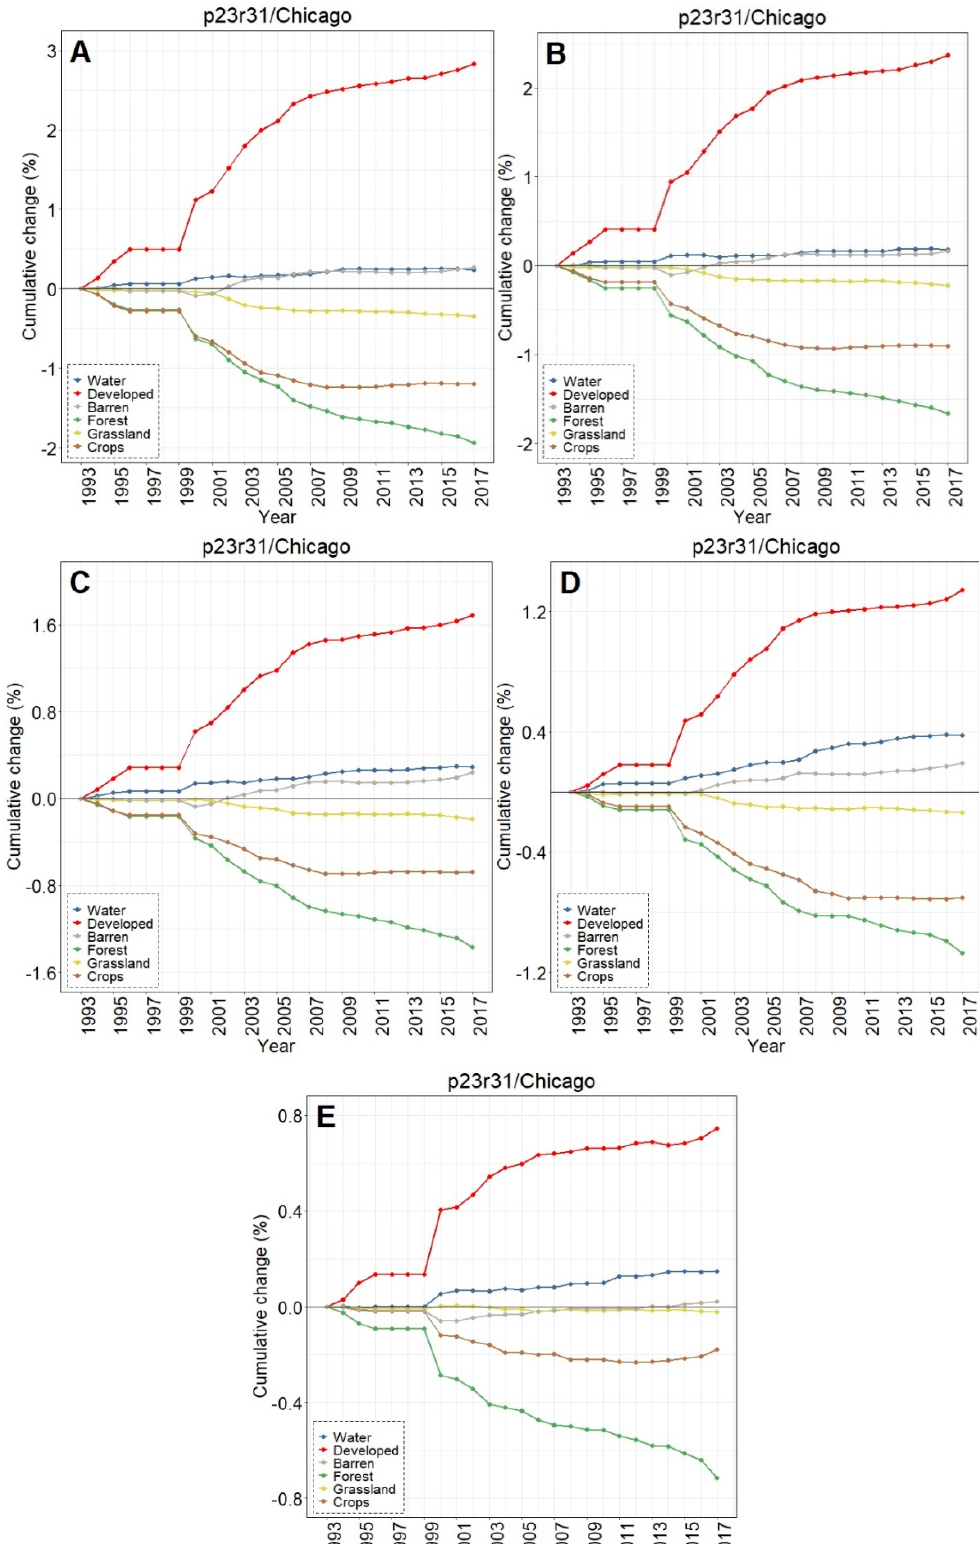
Figure 13. Chicago footprint LULC change over time in surface-water buffers binned into five aquatic system size, ( A ) < 0.1 ha, ( B ) 0.1 to < 1.0 ha, ( C ) 1.0 to < 10.0 ha, ( D ) 10.0 to < 100.0 ha, ( E ) ≥ 100.0 ha. Note the differences in the Y-values between plots.